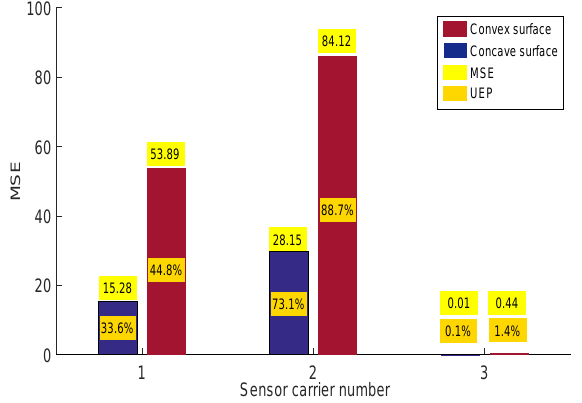
Figure 19. Mean squared error (MSE) and undetected echoes percentage (UEP) of the three sensor carriers for concave and convex surface